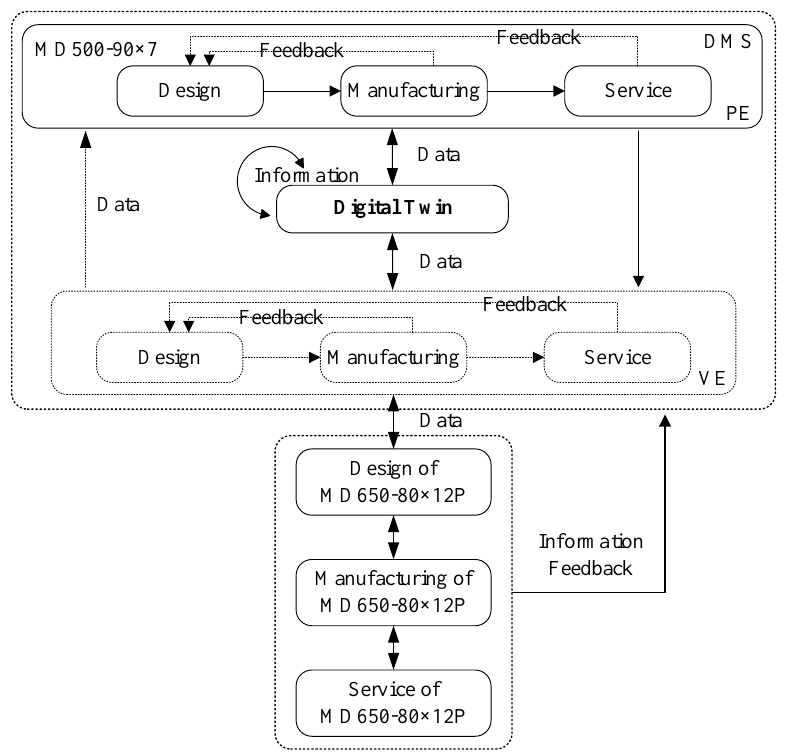
Figure 10. The process of development based on DMS-DT from MD500-90×7 to MD650-80×12P.